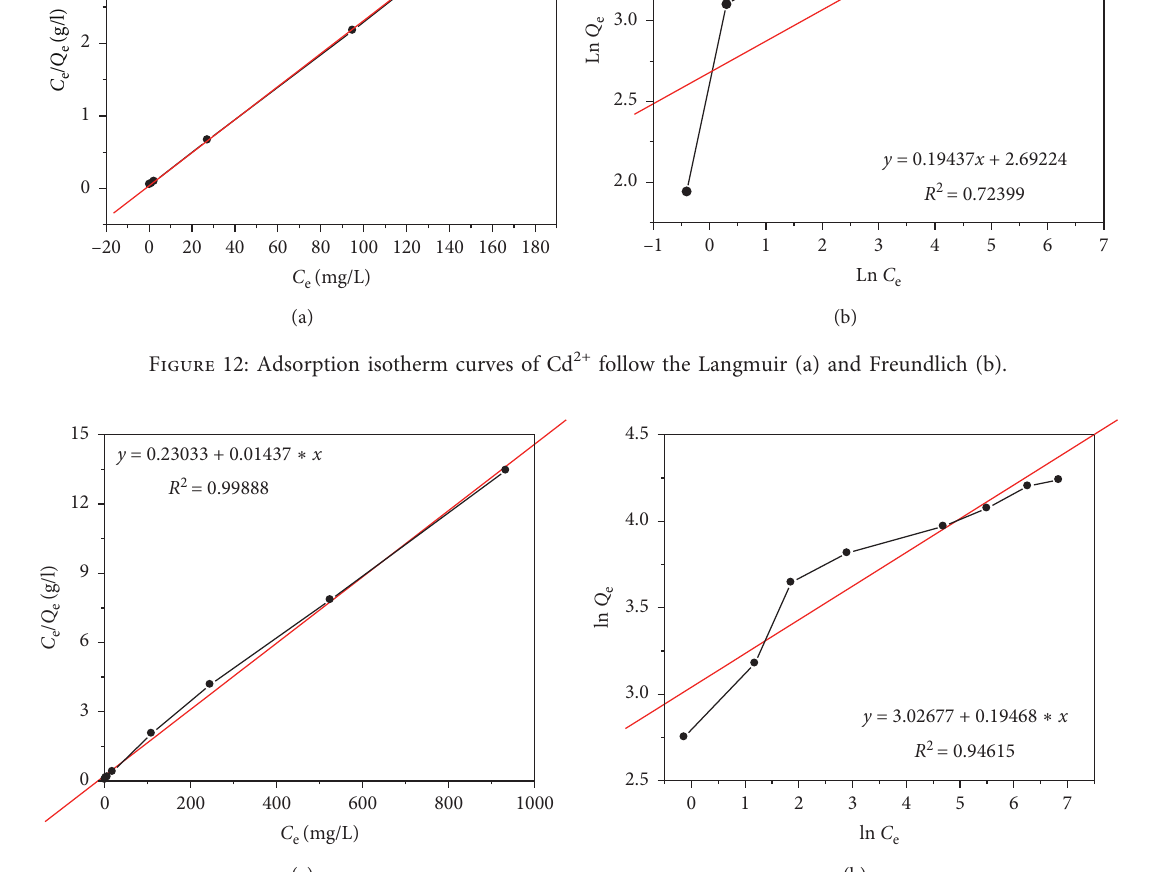
y = 0.02276 x + 0.03854